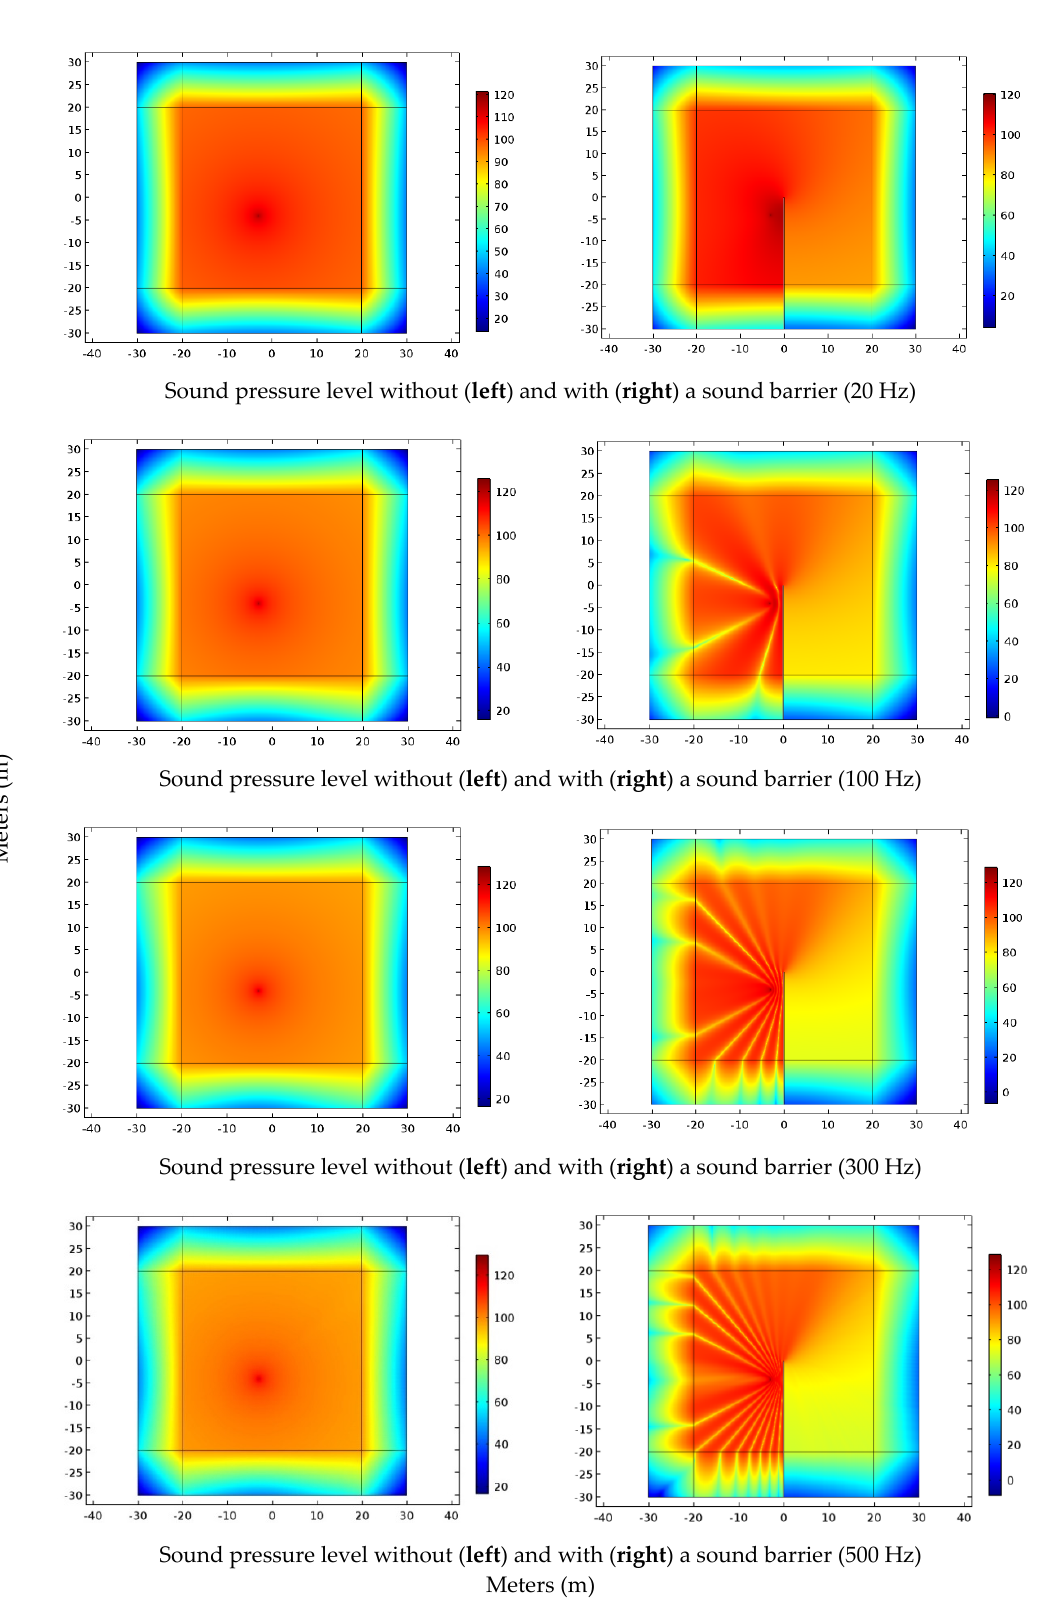
Figure 4. Sound pressure levels of the domain calculated via FEM for different frequencies. Colorbar units are in SPL (dB). Axis units are in meters (m).